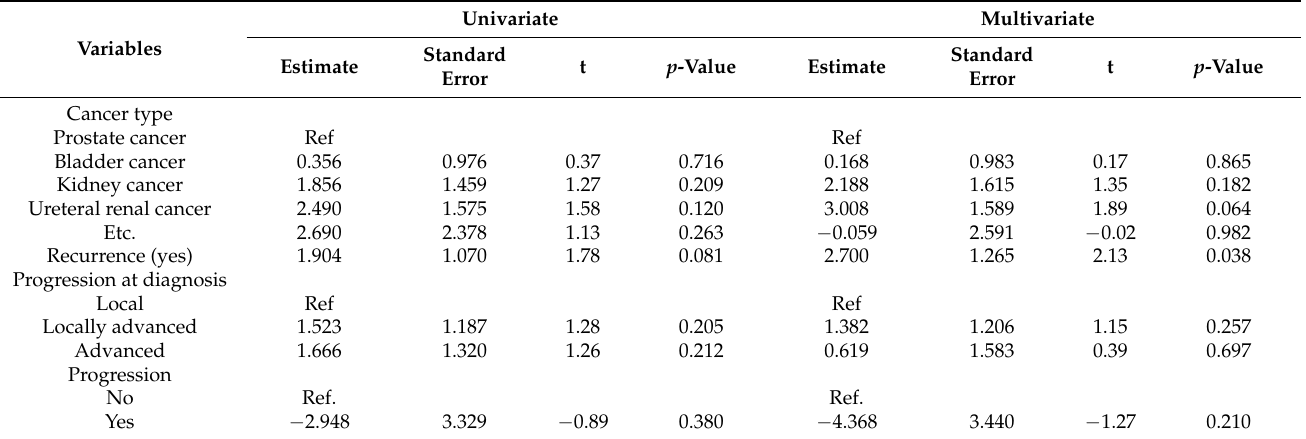
Table 5. Regression analysis of